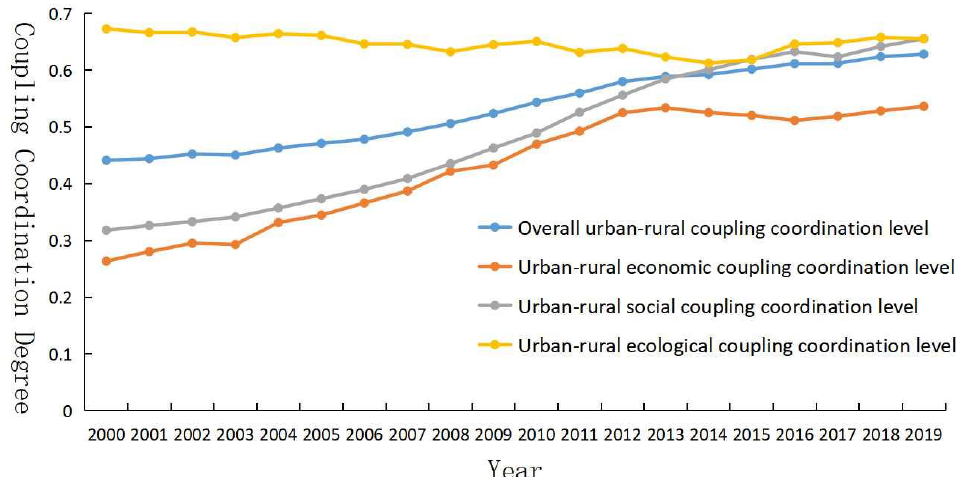
Figure 7. Urban – rural Coupling and Coordinated Development of Northeast China and the Changes of Various Dimensions. of Various